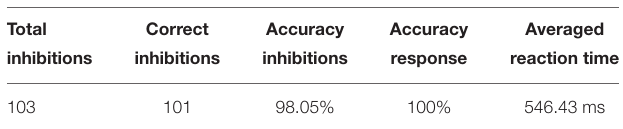
TABLE 2 | Go/No-Go